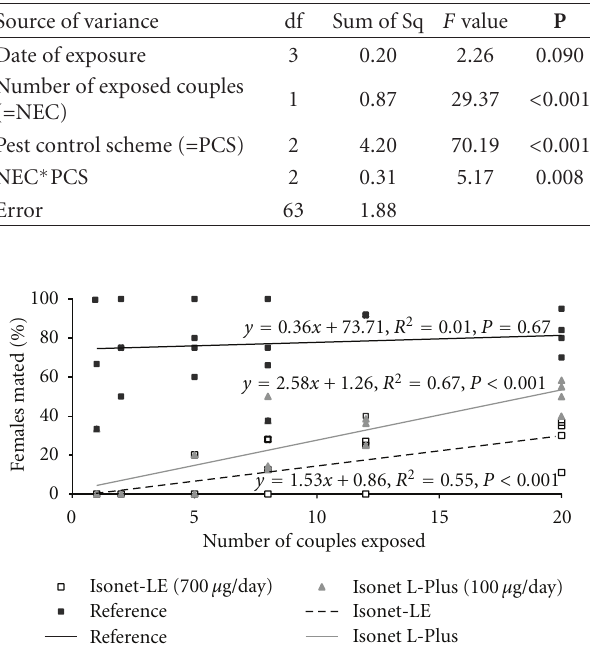
Figure 4: E ff ect of the number of couples exposed on the percentage of E. ambiguella females mated in field cages (mesh size = 1500 µ m, containing no pheromone dispenser). The nota- tion µ g/day represents the approximate daily emission rate of pheromone dispensers for E. ambiguella ; data from the three insect control schemes were fitted with linear regression